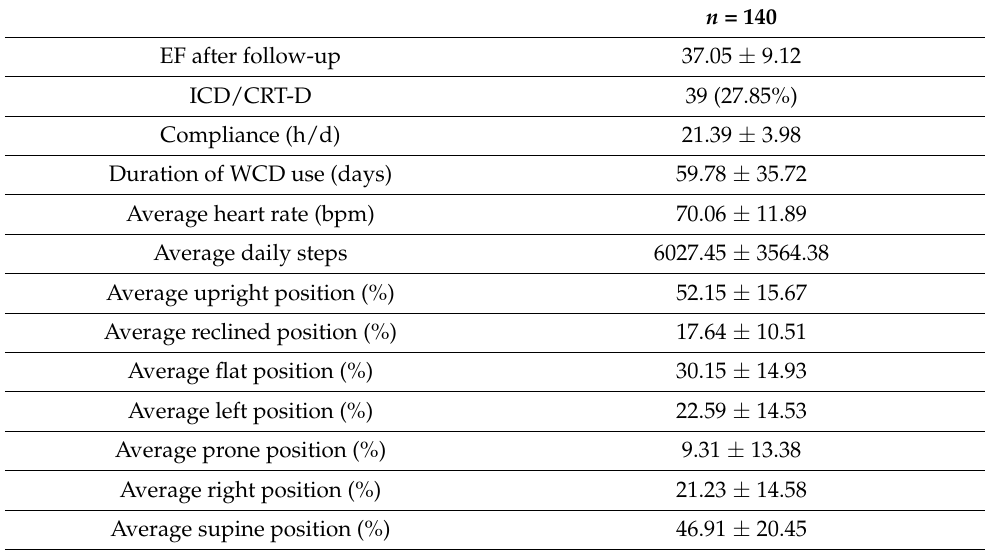
Table 3. Follow-up